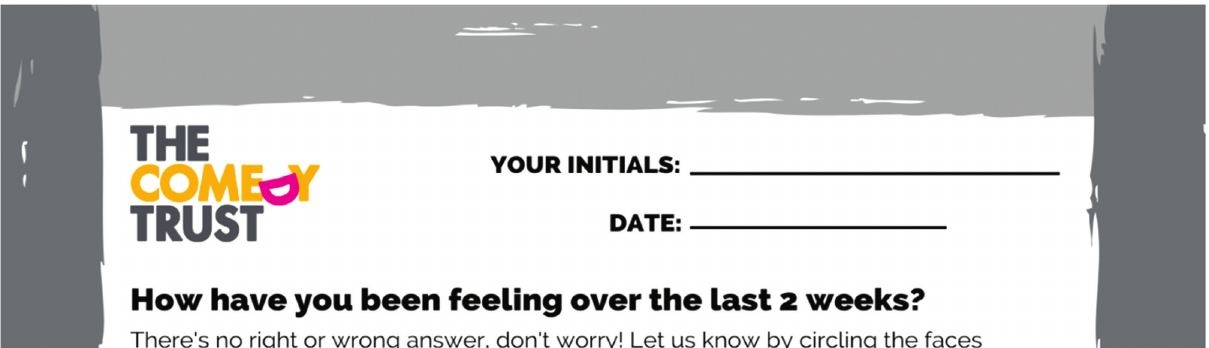
Figure 2. Feeling Funny standard tool, based on SWEMWBS (Source: Authors,